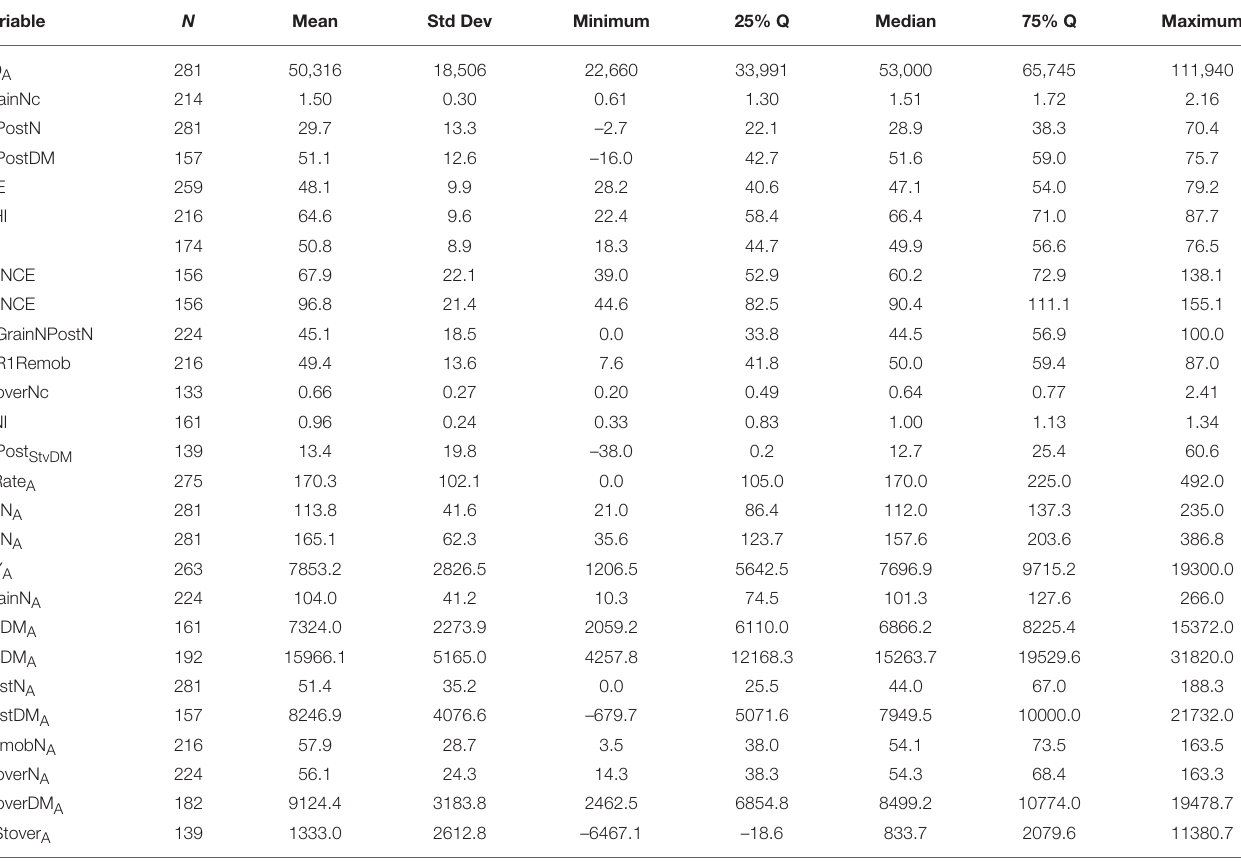
TABLE 2 | Summary statistics based on per unit area for the Old Era data